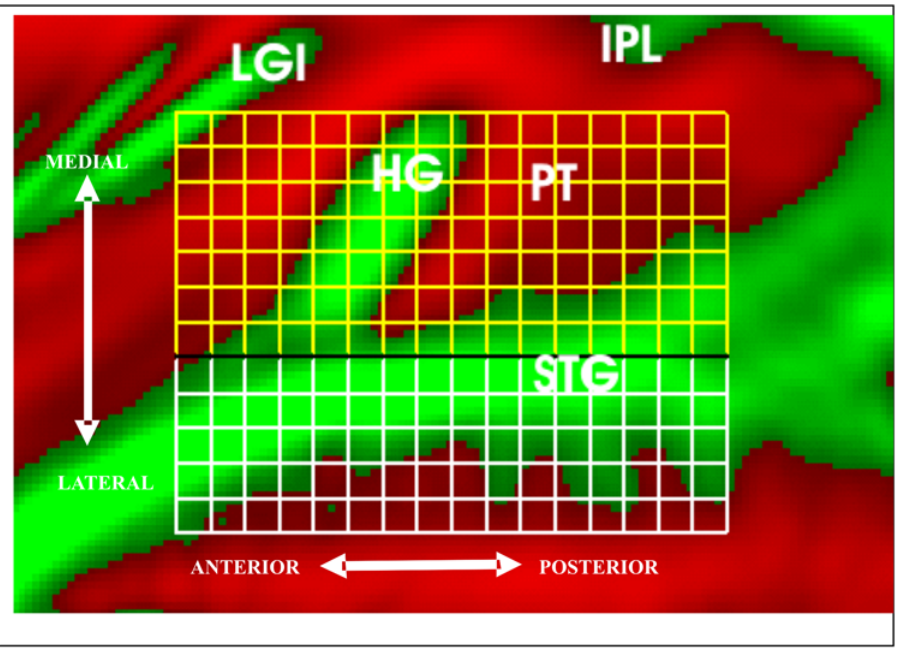
Figure 4. Grid measurement. Activations in auditory cortex were quantified using medial (yellow) and lateral (white) grids. Each grid contained individual grid elements of identical size (approximately 5 6 5 mm) on the inflated cortical surface. Average cortical surface curvature is shown (gyri=green, sulci=red). LGI=long gyri of the insula; HG=Heschl’s Gyrus, IPL=inferior parietal lobe, PT=Planum Temporale, STG=superior temporal gyrus. Approximate anterior-posterior and medial-lateral directions on the inflated surface are shown. doi:10.1371/journal.pone.0005183.g004 Frequency 6 Hemisphere 6 M-L (F (12,96) = 1.02) interactions were also absent, suggesting similar patterns of tonotopic organization in the two hemispheres.